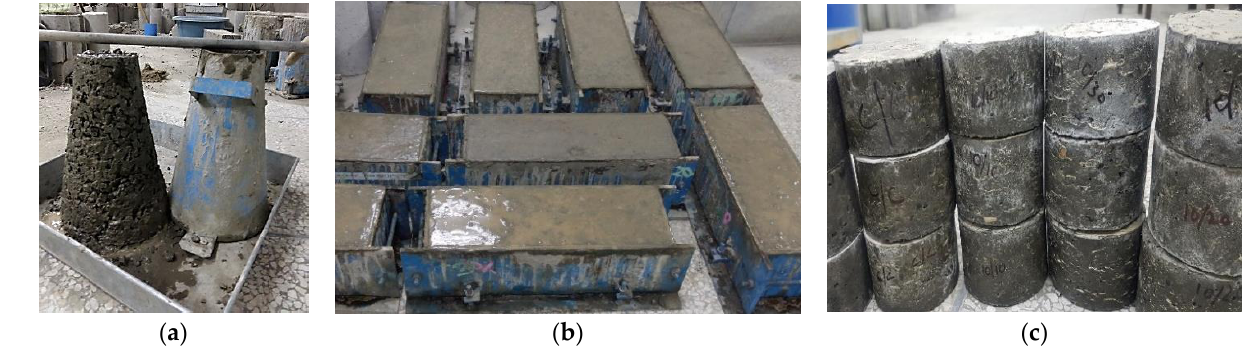
Figure 4. Sample preparation: ( a ) slump test, ( b ) prisms, ( c ) specimens for impact testing.